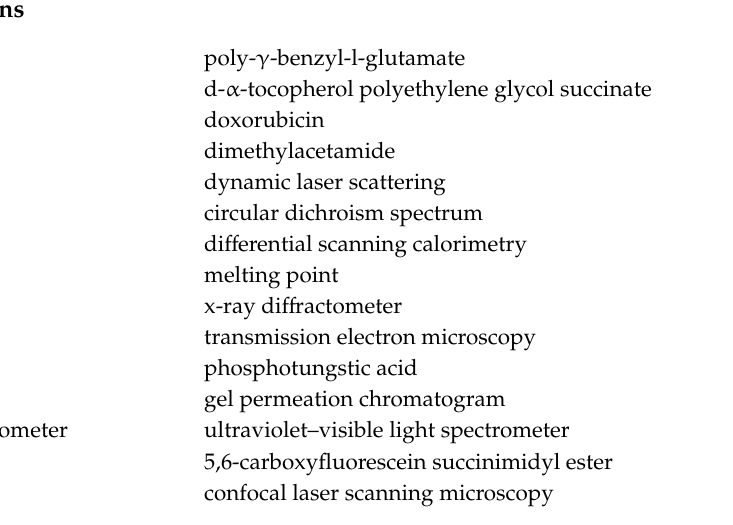
Figure S1: DSC analysis of TPGS, PBLG, TPH and TPM, Figure S2: TEM images of TPH (a) and TPM (b) mixed micelles after incubation at 37 ◦ C for 24 h, Figure S3: The CD spectrum of TPM mixed micelles at pH 7.4, 6.5 and 4.0 conditions after incubation at 37 ◦ C for 24h, Figure S4: DSC analysis of TPGS, PBLG, TPH and TPM at pH4.0, Figure S5: Gel permeation chromatography (GPC) of TPM at di ff erent pH values (7.4 and 4.0) after incubation at 37 ◦ C for 6 and 24 h, Figure S6: Cell viability of bare TPH mixed micelles in human normal cells Detroit 551, Figure S7: The cytotoxicity assay of free Dox, Dox-loaded TPH and TPM micelles was independently conducted on human colon carcinoma cell lines HCT 116, Figure S8: Characterization of TPGS-NH 2